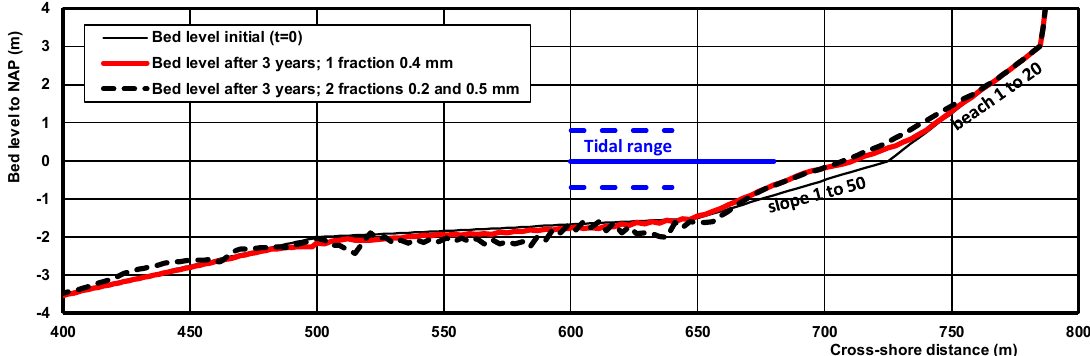
Figure 7. Computed beach accretion for daily wave conditions; CROSMOR-model.